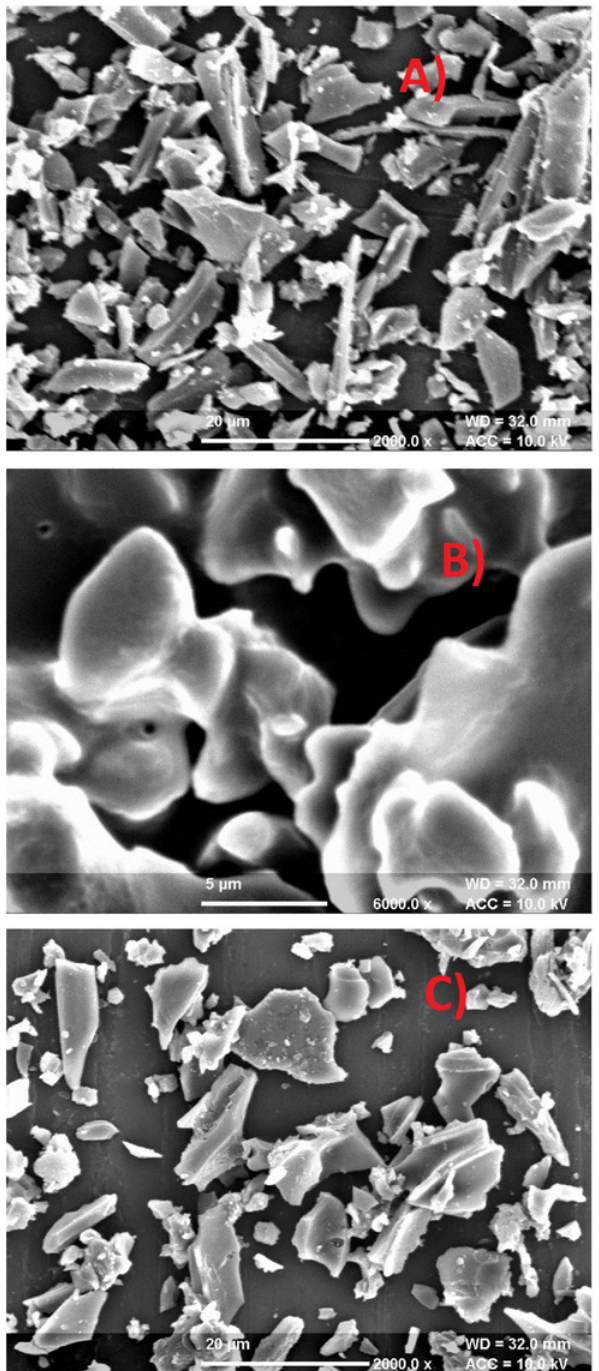
Figure 4: SEM image of (A) pure carbon, (B) pure alum, and (C) maximum conducting